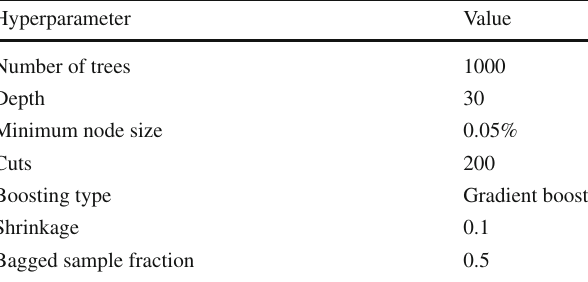
Table 2 List of optimised hyperparameters used in the MV2 tagging